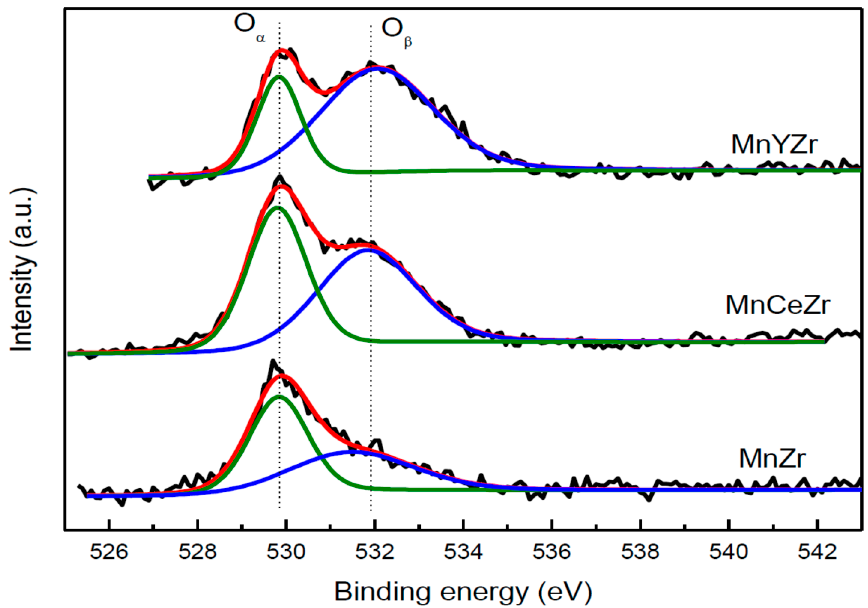
Figure 5. O 1s XPS spectra of catalysts before and after doping of Ce and Y. Catalysts 2017 , 7 , 181